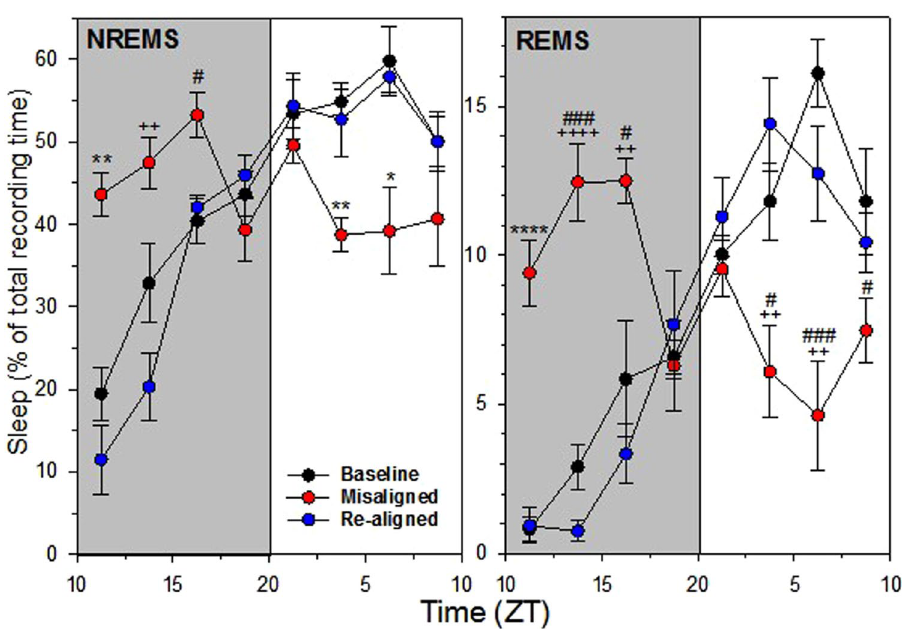
Figure 2. Time course of 2.5 hourly binned values of non-rapid eye movement (NREM) sleep and rapid eye movement (REM) sleep for the baseline T20 cycle (black circle symbols), misaligned T20 (red symbols) and re- aligned T20 cycle (blue symbols), expressed in percentage of recording time per 2.5 h (AVG ± SEM; B6: n = 5). Two and half hourly bins showing a significant effect of T20 cycle (repeated measures ANOVA, P < 0.05) were followed by the TUKEY post-hoc tests (between the three T20 cycles): Asterisks ( * P < 0.05; ** P < 0.01; **** P < 0.0001) indicate that the misaligned cycle is different from both, baseline and re-aligned T20 cycles; plus symbols ( ++ P < 0.01; ++++ P < 0.0001) display that the misaligned T20 cycle is different from the re-aligned T20 cycle only; and # symbols ( # P < 0.05; ### P < 0.001) show that the misaligned T20 cycle is different from the baseline T20 cycle